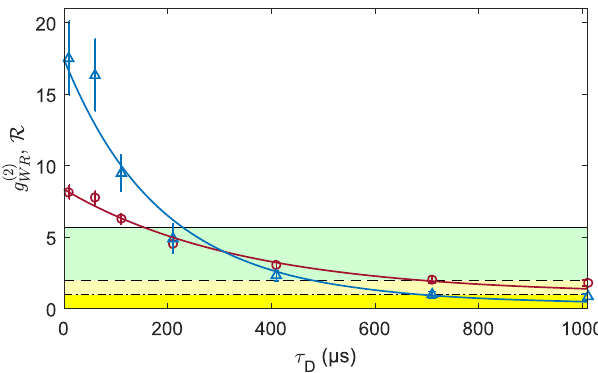
(red) and Fig. 4 Photon correlations for delayed readout. Shown are g ð 2 Þ WR the Cauchy-Schwarz parameter R (blue) versus various read pulse delays τ μ s together with the fi t to g ð 2 Þ D for an integrated read pulse duration of 40 WR (red line) and the resulting R (blue line). The black line marks the Bell- ≥ 5.7 and the dashed line marks the typical non- inequality limit g ð 2 Þ WR classicallity signature g ð 2 Þ > 2. The dash-dotted line is the formal non- WR classicallity criterion R > 1. Error bars represent one standard deviation. Source data are provided as a Source Data fi i.e., not ful fi lling R > 1 (Fig. 4, dash-dotted line). We use R as a formal non-classicality bound instead of the typical signature ð 2 Þ g > 2 21 . The corresponding memory time is WR ¼ ð 0 : 68 ± 0 : 08 Þ ms. The limit for violating the Bell inequality τ R NC